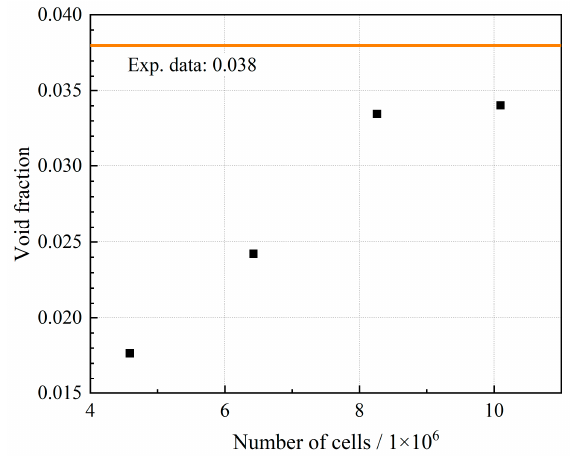
Figure 2. Numerical validation and mesh independence